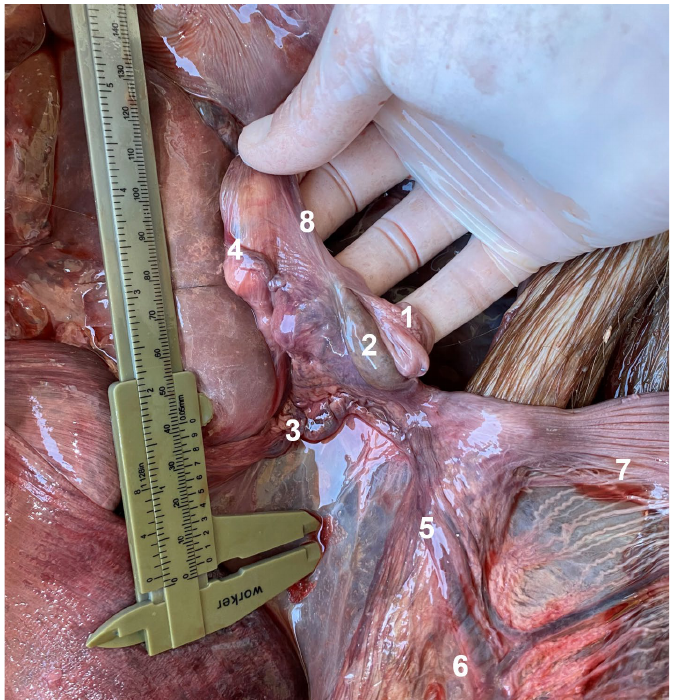
Figure 9. Vascular anatomy of reproductive organs, left approach. 1. uterine tube; 2. ovary; 3. ovarian vein giving rise to the tubal branch (4) and uterine branch (5) that anastomoses with the uterine vein (6); 7. left uterine horn; 8. suspensory ligament of the ovary.